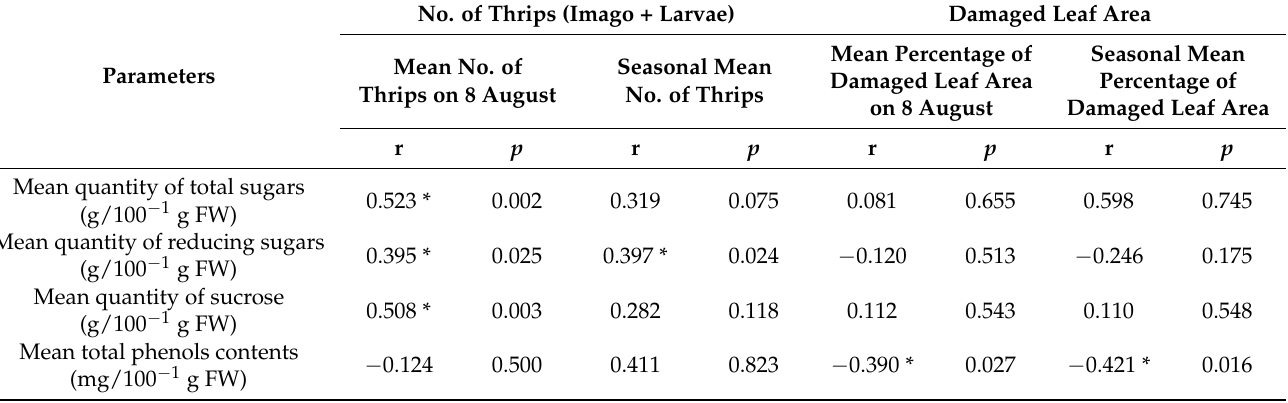
Table 6. Pearson’s correlation between biochemical characteristics of onion leaves and the number of Thrips tabaci and percentage of damaged leaf area of onion leaves in 2016 ( n =